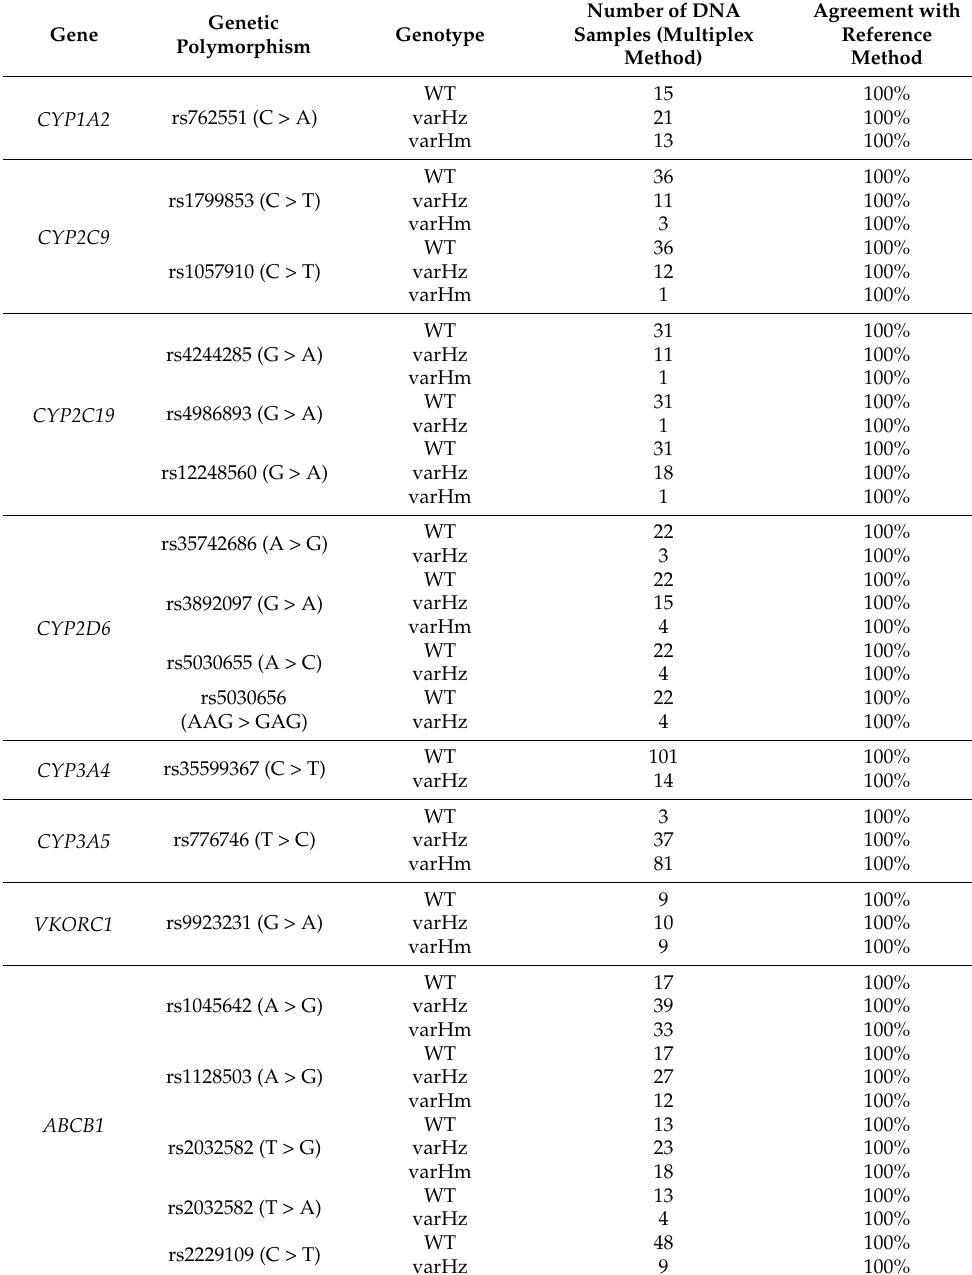
Table 4. Accuracy of the assay, comparison of genotyping results with reference